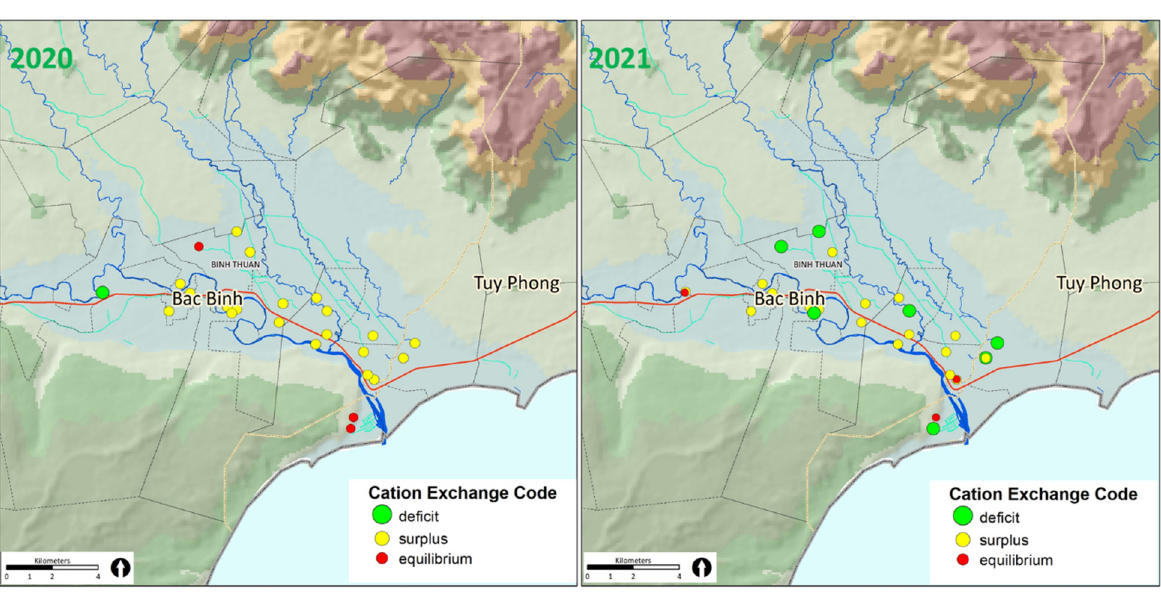
Figure 12. Distribution of the cation exchange codes of 33 water samples collected in 2020 and 2021. The water samples collected in 2020 and 2021 at the same locations are plotted in the HFE diagram to observe the water faces variation during the time periods (Figure